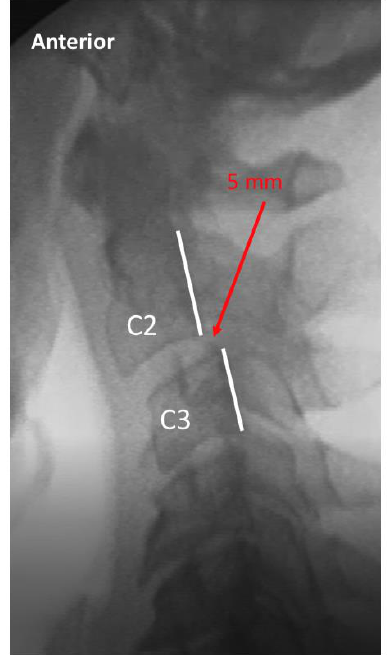
Figure 4. Exemplar of lateral cervical flexion view, demonstrating abnormal alignment of C2 on C3. The dashed line indicates the posterior margin of the vertebral body of C2, and the solid line indicates the posterior margin of the vertebral body of C3. The red arrow indicates 5 mm of anterior translation of C2 on C3 upon maximal voluntary flexion, which is limited due to pain.